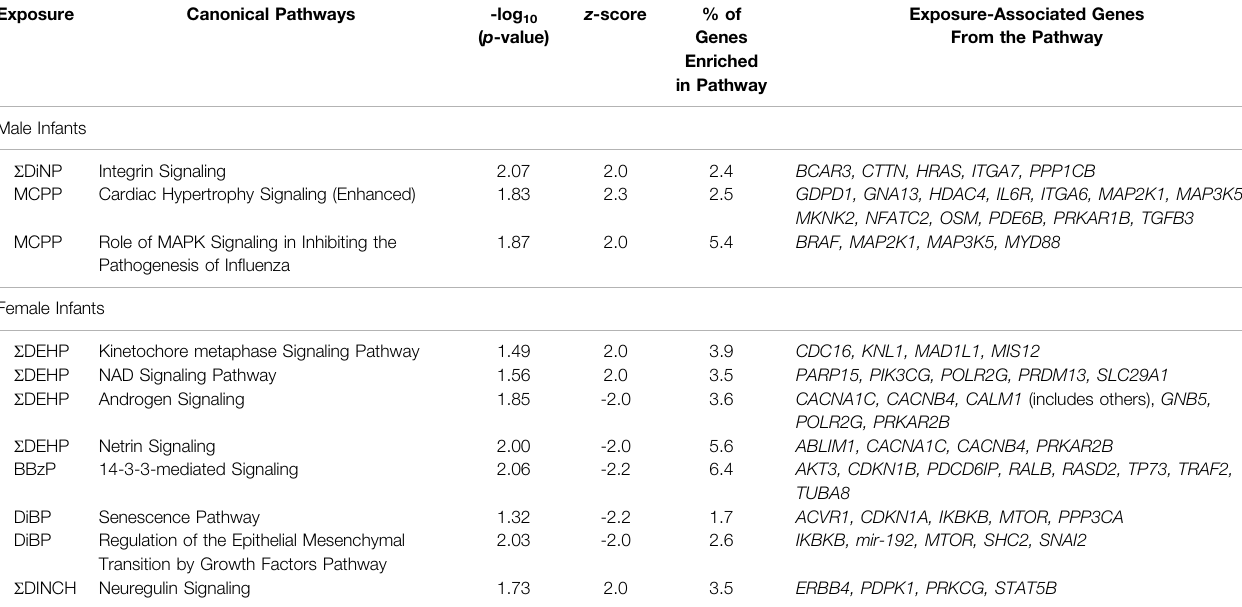
TABLE 4 | Signi fi cant Canonical Pathways Enriched among CpG Sites Associated with Phthalates at p < 0.001.